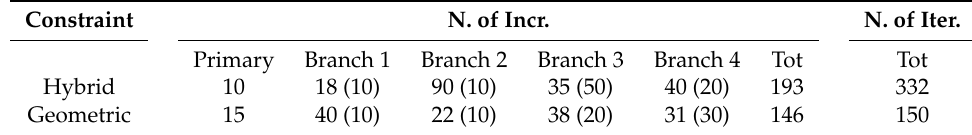
Table 1. Number of increments using different constraint equations. (˜ τ in the parenthesis).